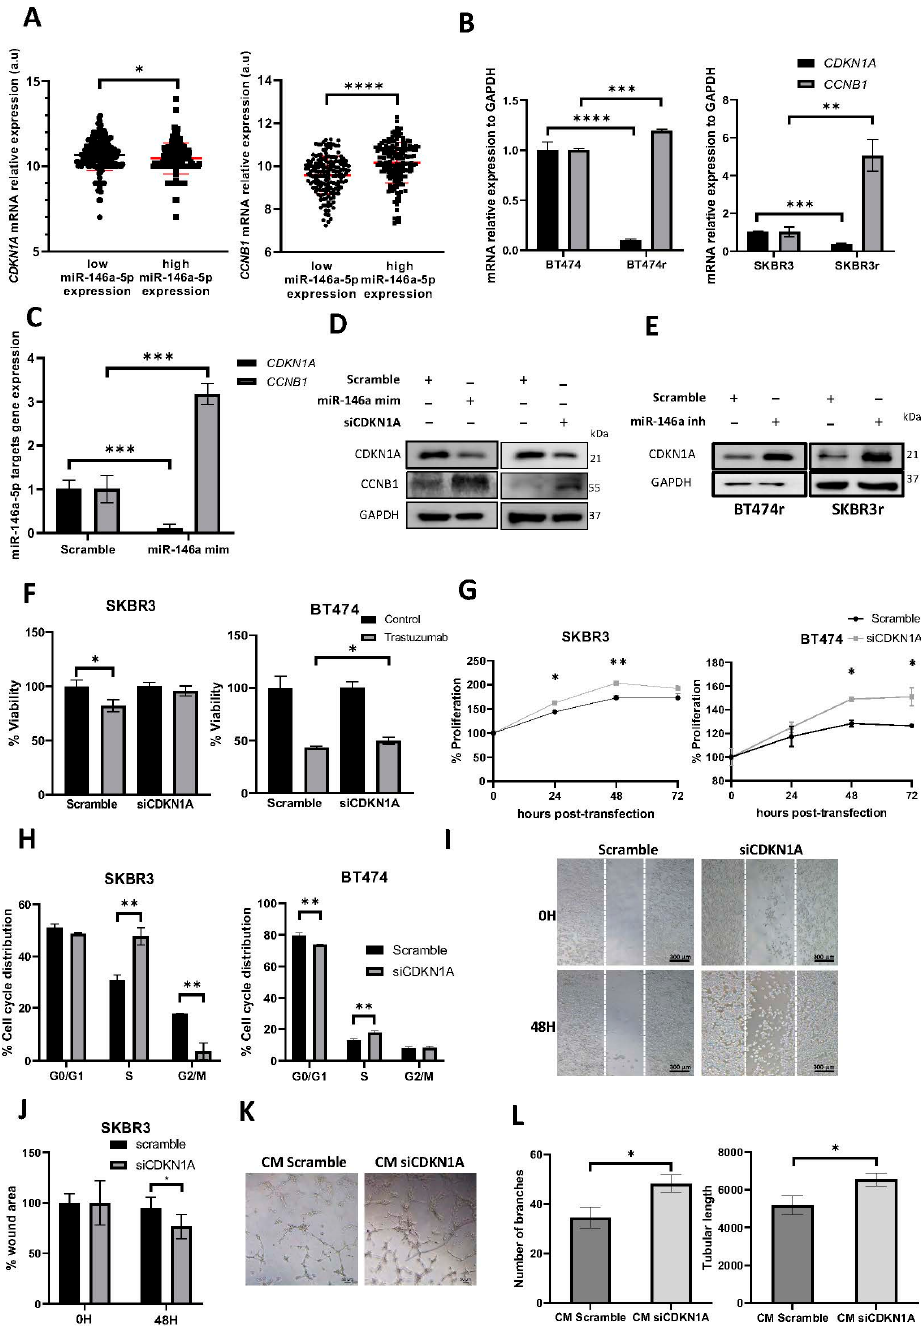
Figure 4. CDKN1A modulates the response to trastuzumab, proliferation, cell cycle, migration, and angiogenesis. ( A ) Data from TCGA dataset (n = 333) were classi fi ed based on median miR-146a-5p expression in breast tumor sample, and CKDN1A and CCNB1 expression were represented. ( B ) An analysis via RT-qPCR of CDKN1A and CCNB1 expression in BT474/BT474r, and SKBR3/SKBR3r cell lines, ( C ) or in BT474 transfected with miR-146a-5p mimic. GAPDH was used as endogenous mRNA. ( D ) Analysis via Western blot of CDKN1A and CCNB1 in BT474 after miR-146a-5p mimic or small-interfering (siRNA) targeting CDKN1A (siCDKN1A) transfection, ( E ) and in BT474r and SKBR3r after miR-146a-5p inhibitor transfection. GAPDH was used as a loading control. ( F ) Viability analysis of SKBR3 and BT474 transfected with siCDKN1A, treated or not with 15 µg/mL of trastuzumab for 7 days. ( G ) Proliferation analysis of SKBR3 and BT474 cell lines after 0, 24, 48, and 72 h after siCDKN1A transfection. ( H ) Cell cycle distribution of SKBR3 and BT474 cells transfected with siCDKN1A. ( I ) Wound-healing cell migration assay of SKBR3 transfected with siCDKN1A, 5× Magni fi cation. Scale bar: 300 µm. ( J ) Quanti fi cation of the wound remaining area at 0 and 48 h post- transfection. ( K ) Representative images of in vitro angiogenesis assay of HUVEC-2 cells 8 h after addition of CM after 24 h of SKBR3 transfected with siCDKN1A or scramble control. Magni fi cation: